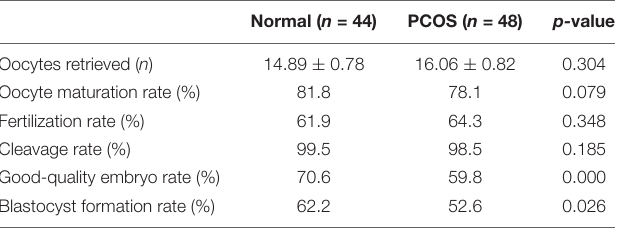
TABLE 2 | IVF-ET laboratory indicators in normal and PCOS patients.